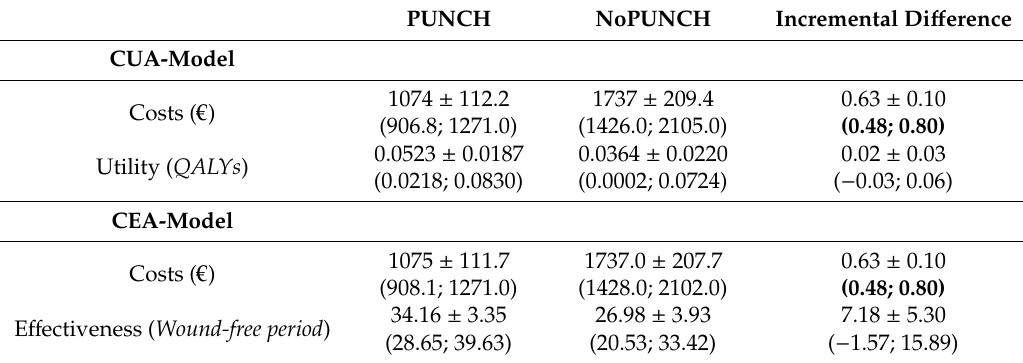
Table 4. Statistical summary of costs, utility, and e ff ectiveness (100,000 simulations MCMC).